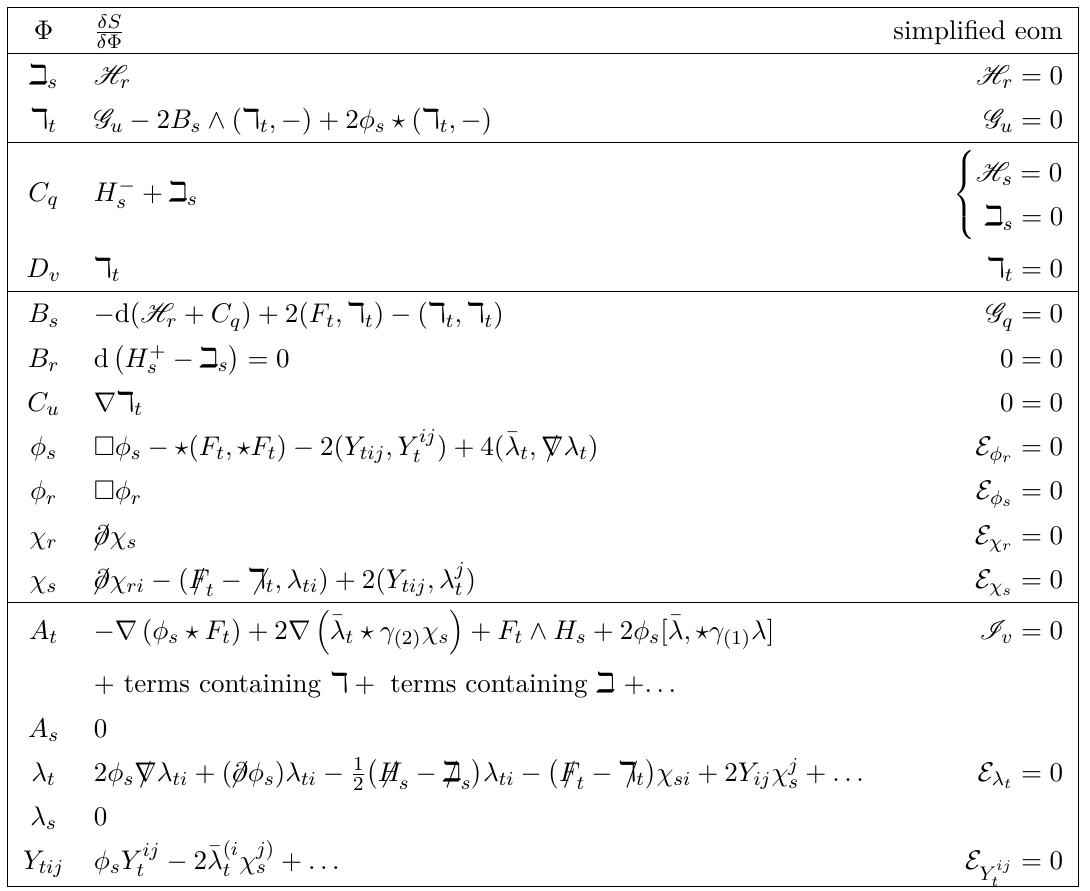
Table 2 . The (normalized) variations of S with respect to the various fields and the resulting simplified equations of motion. The expressions E χ , E φ , E λ , and E denote terms originating from the hypermultiplets. We use again Feynman slash notation, cf. ap- pendix C. Note that the equation I v = 0 is obtained from the equation for Φ = A t , combined with the equation for Φ = k t